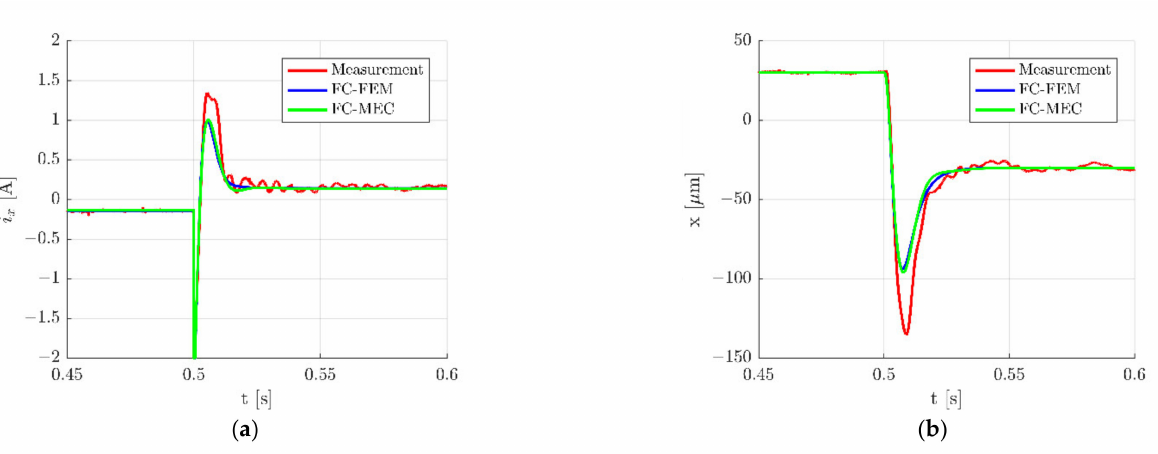
Figure 11. Zoom of time responses of the control current i x ( a ) and the rotor position x ( b ) for the step change ± 30 µ m along the x -axis. The results obtained for the y -axis are presented in Figures 12 and